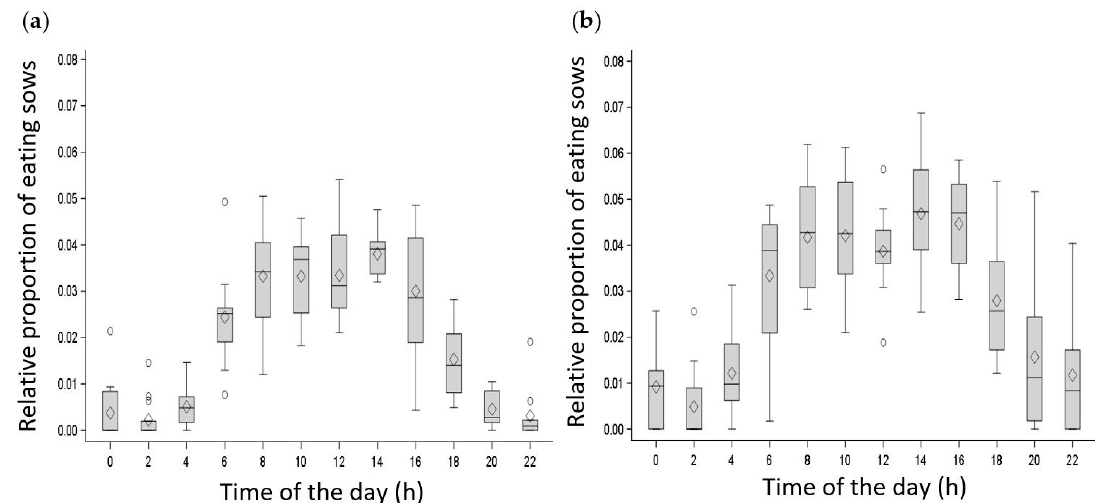
Figure 3. Feed intake rhythm in ( a ) the low-energy and ( b ) high-energy feeding areas of the Sow-Welfare-Optimized-Feeding (SWOF) system expressed as the relative part of eating sows from all the sows in the system. Boxplots indicate data range as well as median and lower and upper quartiles. The diamonds indicate the means. Thick gray lines are the 95% confidence intervals, whereas gray circles represent individual sows.